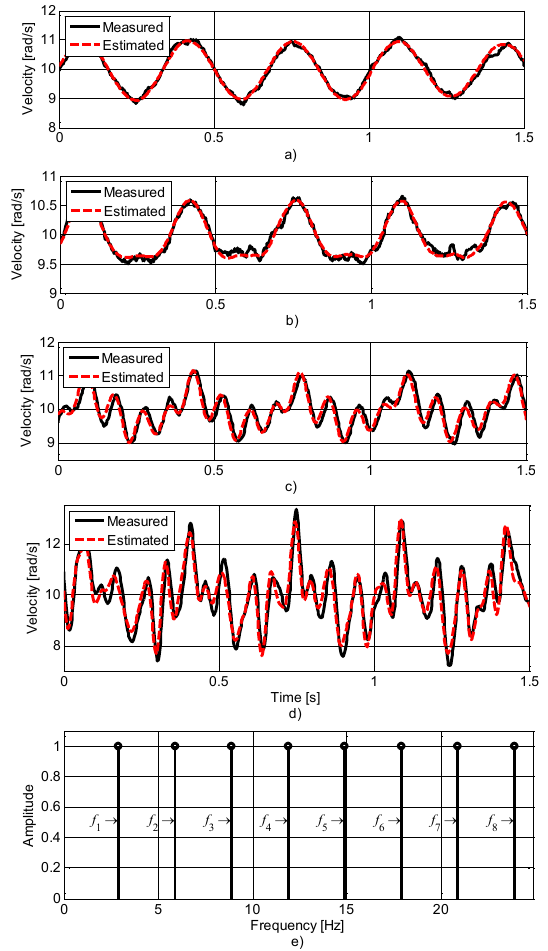
Figure 5: Estimated velocity compared with the mea- sured velocity. a) The system is excited with f , b) with f and f , c) with f - f , and d) 1 1 2 1 4 with f - f . e) The frequency contents of the 1 8 multisine signal with a frequency range of 2.9 Hz to 23.9 Hz with a frequency resolution of 3Hz.